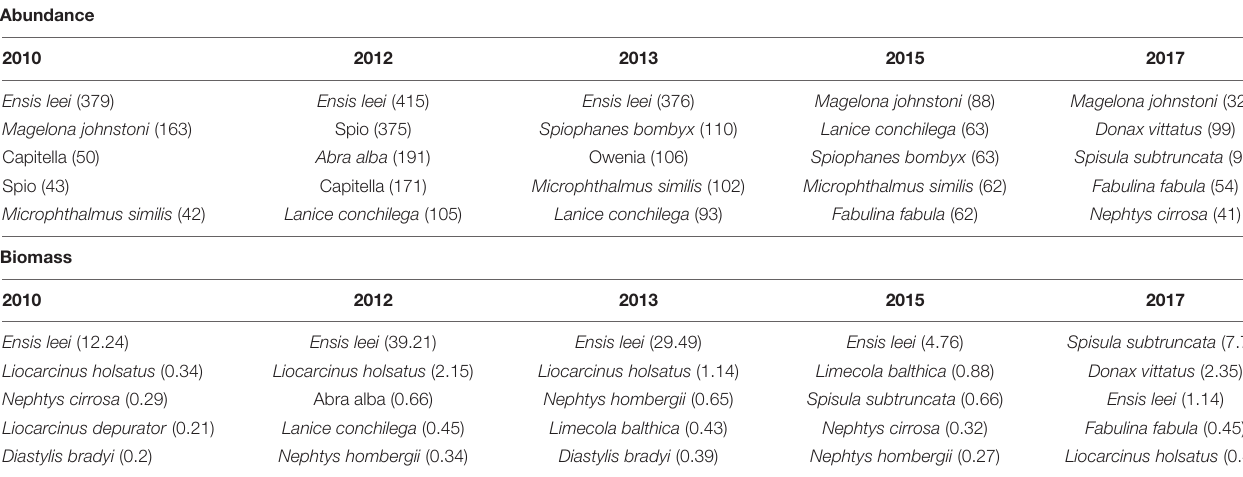
TABLE 1 | Most important species with respect to abundance (ind.m − 2 ) and biomass (gAFDW.m − 2 ) in the five sampling years. Abundance